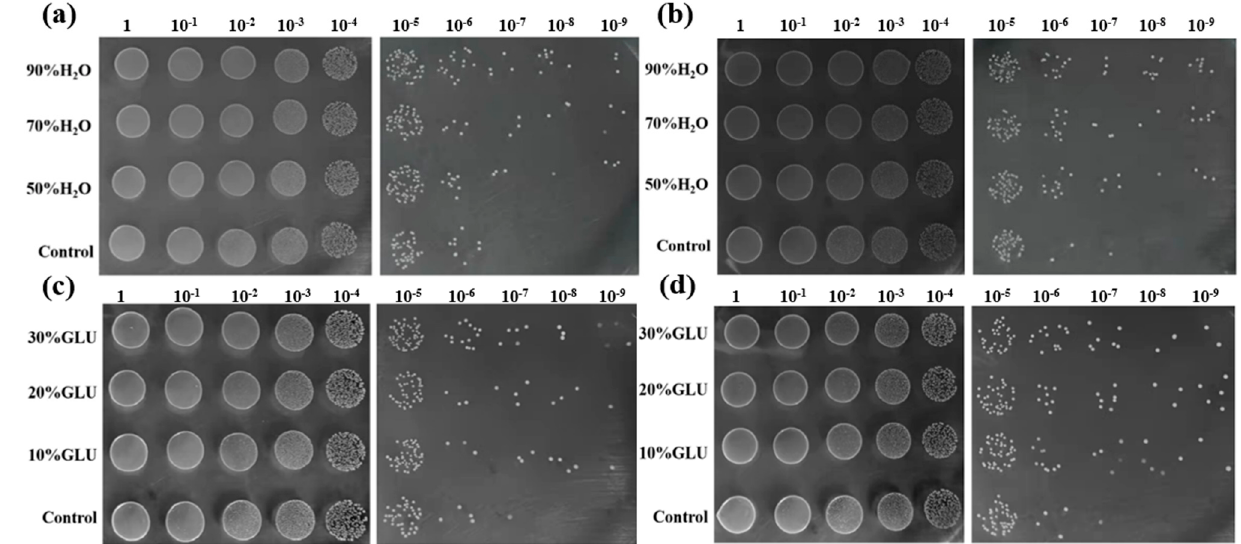
Figure 3. Viable count of Lactobacillus plantarum after ( a ) PPI-CDs or ( b ) N, S-PPI-CDs solution (0.01 g/mL) replaced partial water, and ( c ) PPI-CDs or ( d ) N, S-PPI-CDs replaced partial glucose (GLU) (the dilution ratio of bacterial solution is 1 → 10 9 ).